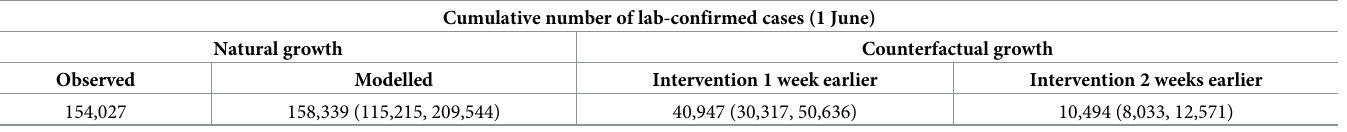
Table 2. Total number of COVID-19 cases for three simulated scenarios.